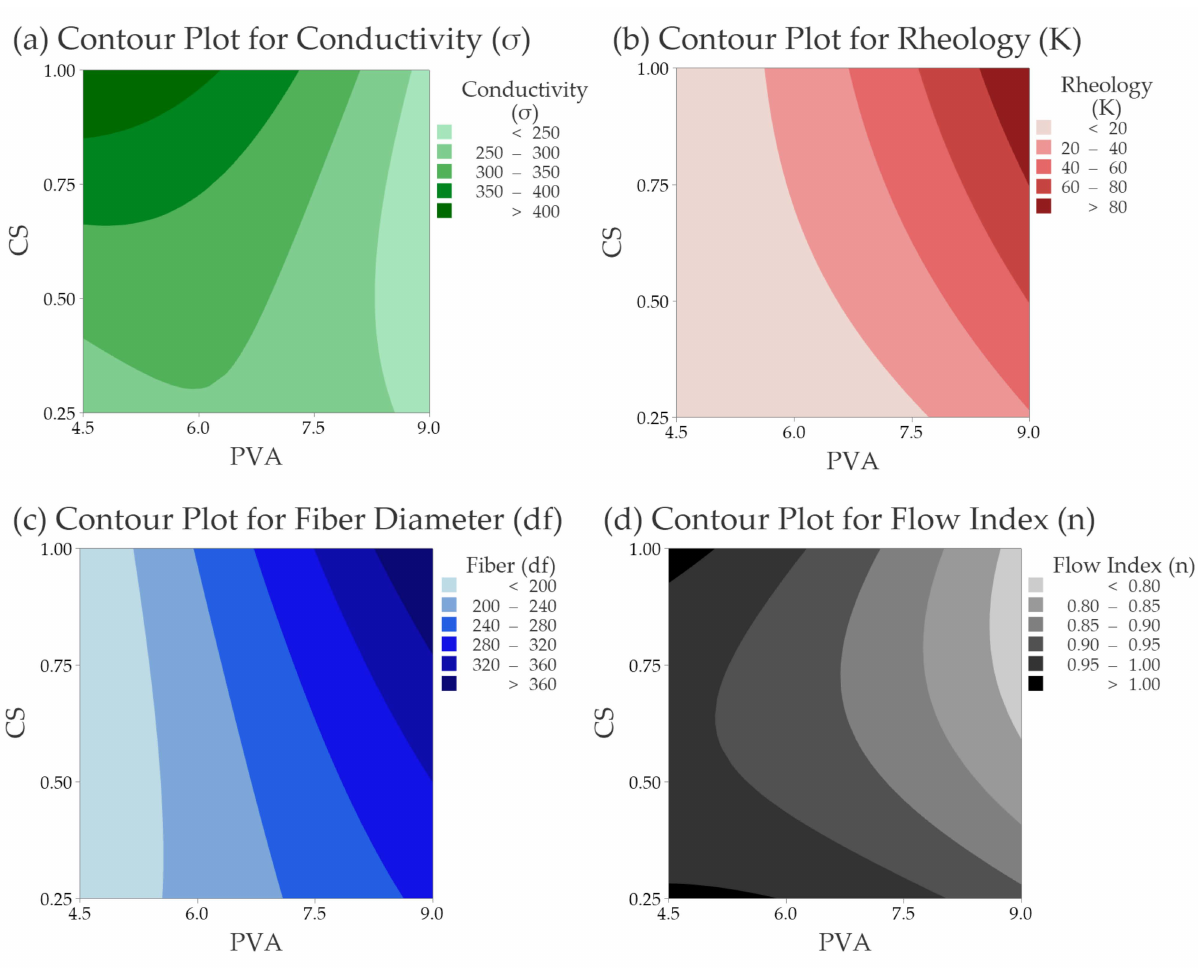
Figure 4. Contour plots generated by regression models for each experimental response: ( a ) Electrical conductivity; ( b ) rheology consistency index (K); ( c ) fiber diameter; and ( d ) flow